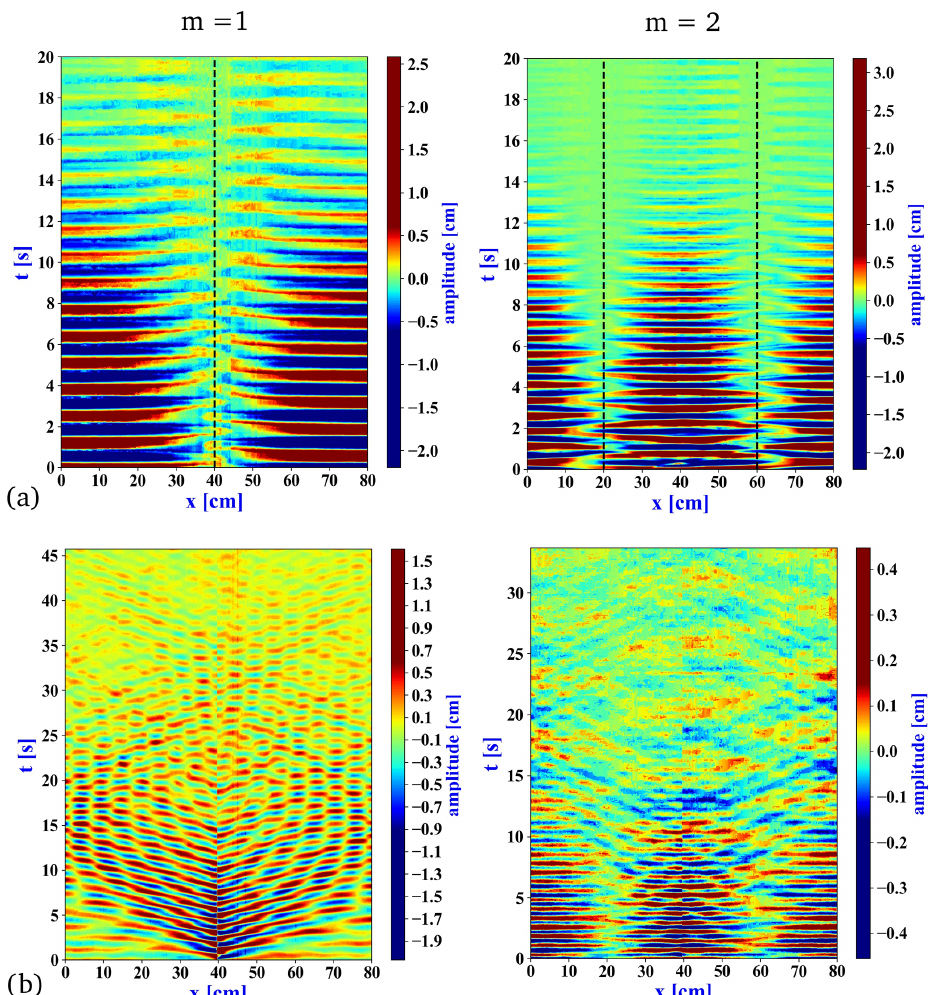
Figure 4. Space–time plots of the two experiments of Fig. 3, showing the vertical displacement of the surface η(x,t) (a) and the pycnocline χ(x,t) (b) in the whole tank for dominant surface wave modes m = 1 (left) and m = 2 right (obstacle location is at x = 40cm). Vertical dashed lines in the top panels denote the expected locations of